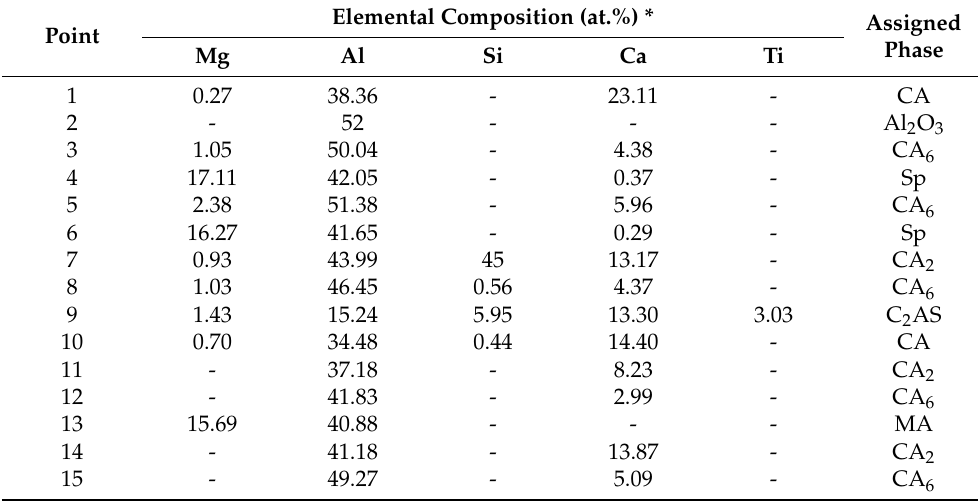
Figure 12. SEM images of sample Al-1-1 corroded by slag R (1350 °C, 10 h); ( a , b ): hot-face (slag/re- fractory interface); ( c , d ) higher magnification of interface zone.